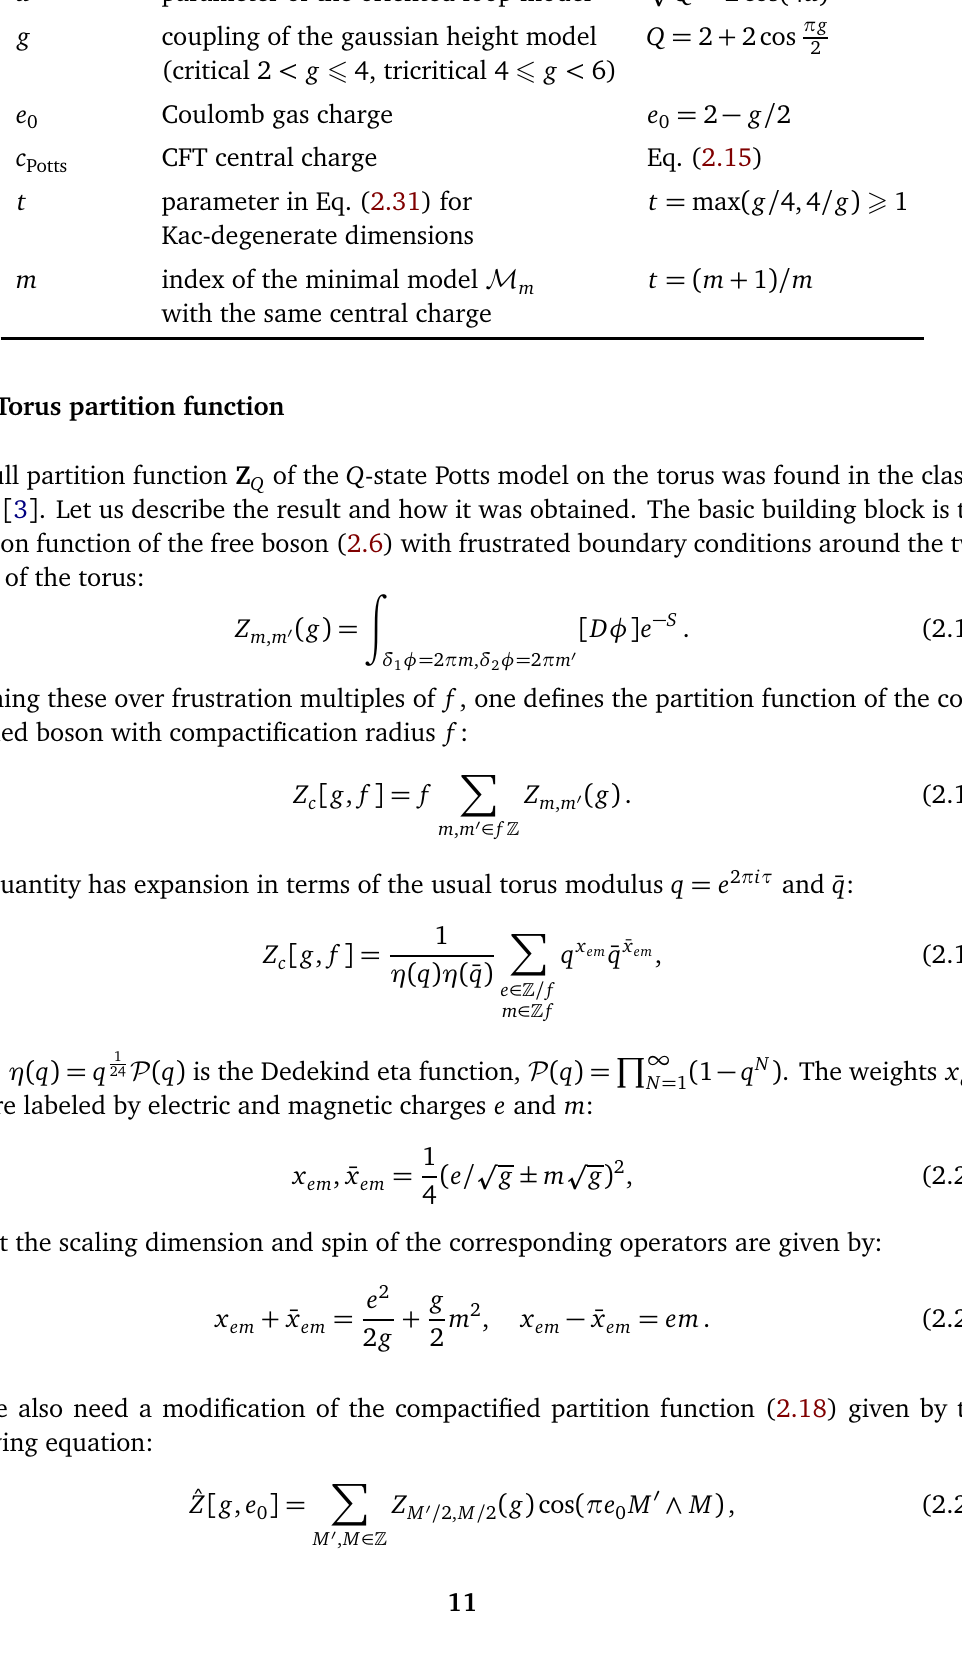
Table 1: Main relations between parameters characterizing the Q -state Potts model. See section 2.3 for u , g , section 2.4 for e , c , and section 2.5 for t , m . 0 Potts Parameter Meaning Relation (cid:112) u parameter of the oriented loop model Q = 2cos ( 4 u ) g coupling of the gaussian height model (critical 2 < g (cid:54) 4, tricritical 4 (cid:54) g < 6) Coulomb gas charge CFT central charge Eq. (2.15) parameter in Eq. (2.31) for t = max ( g / 4,4 / g ) (cid:62)